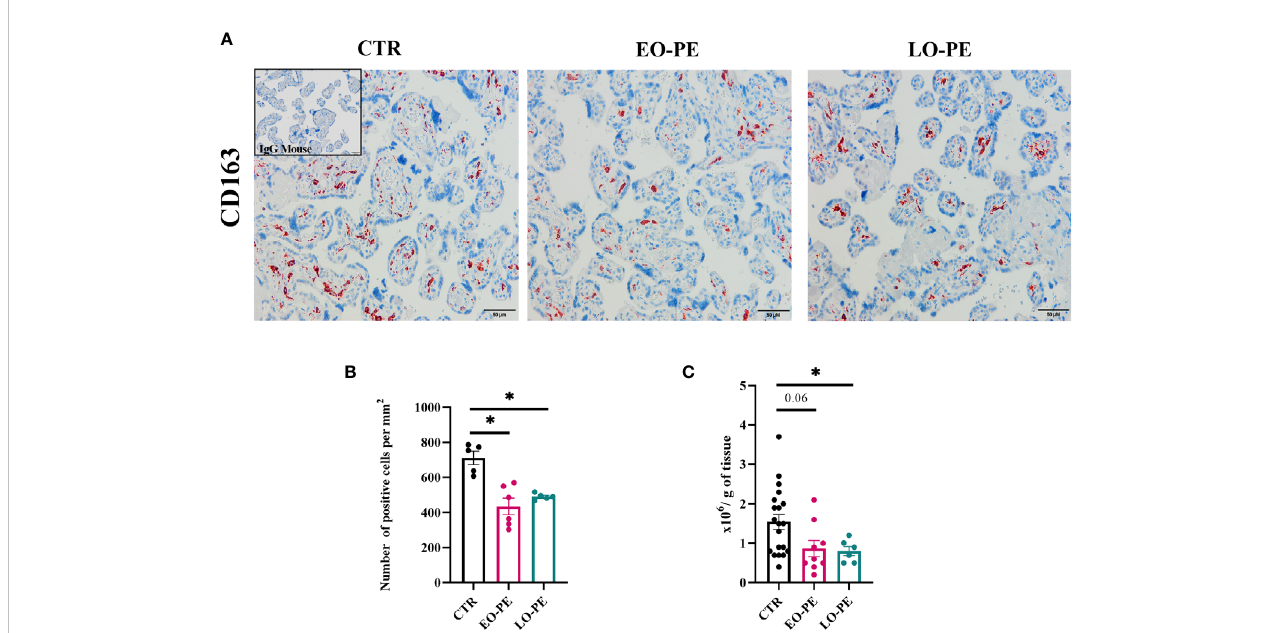
FIGURE 1 Immunohistochemical assessment of CD163 in placental tissue. (A) Representative images of serial sections of CTR (n=5), EO- (n=6) and LO-PE (n=6) are shown. Insert in the top right corner of CTR image depicts negative control stainings (blue). Images were taken at 20x magni fi cation, scale bar represents 50µm. (B) Quanti fi cation of cells positive for CD163 in CTR, EO- and LO-PE group. Cells were quanti fi ed by using Quapath software. (C) Average yield of HBCs, adjusted to the wet weight (in grams) of minced tissue for each respective isolation, CTR (n=22), EO-PE (n=8), LO-PE (n=6). Data on (B) in (C) graphs are presented as mean ± S.E.M, ANCOVA with adjustment for gestational age, followed by Sidak ’ s post-hoc test to examine statistical signi fi cance, *p ≤